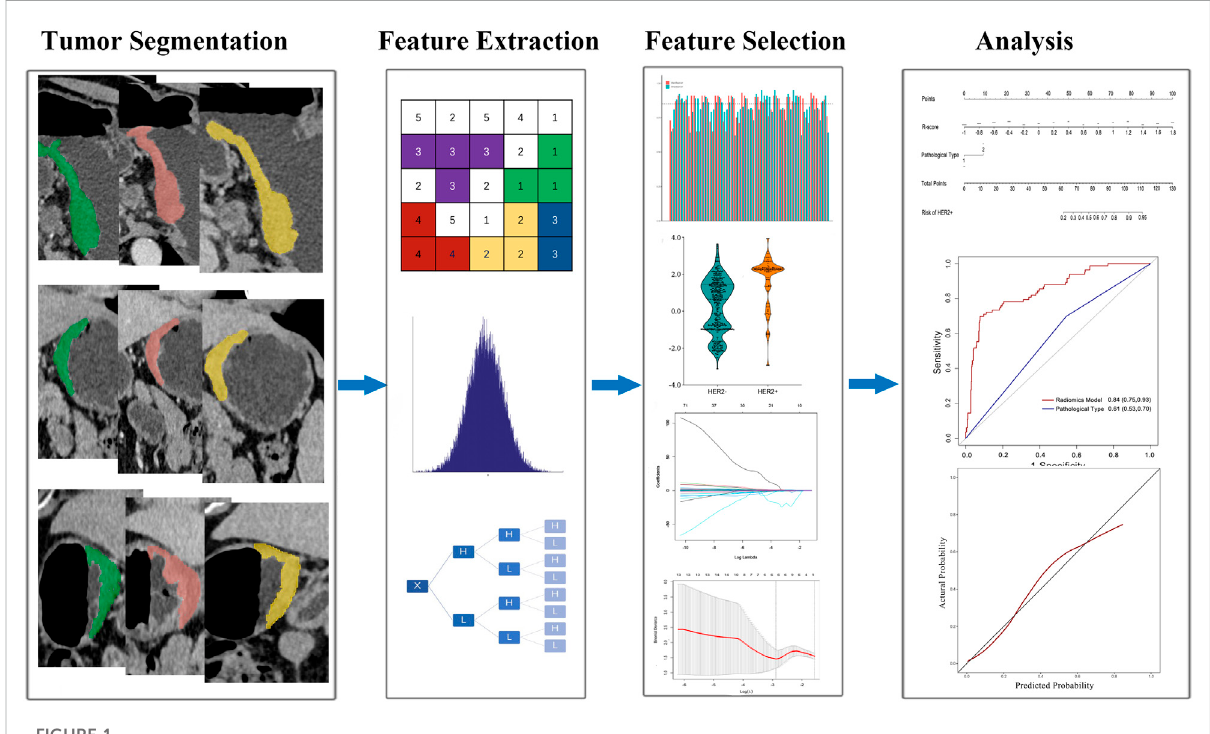
FIGURE 1 Flowchart of study